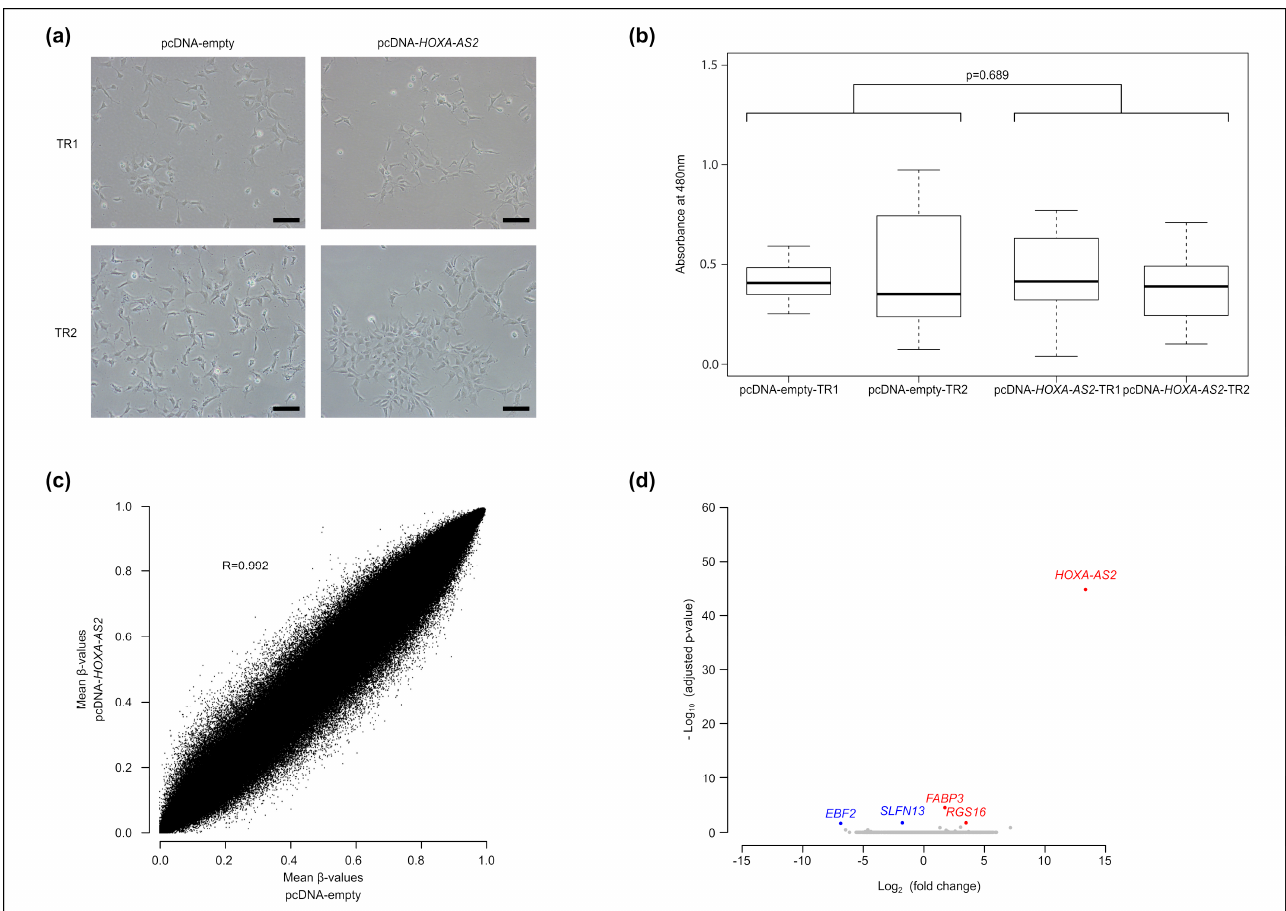
Figure 3. HOXA-AS2 overexpression in the H9-NSC line. ( a ) Representative images of the morphol- ogy of HOXA-AS2 -expressing (right panels; n = 2) and control (left panels, n = 2) H9-NSC lines. These cell lines were obtained from two independent transfections, referred to as TR1 and TR2, respectively. ( b ) Colorimetric assay ( n = 5) to quantify cell proliferation in the two HOXA-AS2 -expressing H9-NSC lines and their respective control line. ( c ) Infinium Methylation EPIC BeadChip data were used to produce scatter plots to correlate DNA methylation patterns of HOXA-AS2 -expressing ( n = 2) and control ( n = 2) H9-NSC lines. ( d ) Volcano plot of differential gene expression in HOXA-AS2 -expressing ( n = 2) and control ( n = 2) H9-NSC